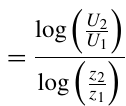
Figure 14. TI vs. R B . The blue box represents where both TI and R B agree on the stable conditions; the percentage (15%) represents the percentage of data points in this box. The red box represents where both TI and R B agree on the unstable conditions; the per- centage (17%) represents the percentage of data points in this box. Includes data filtered for tower 80m wind speeds between 3.5 and 25ms − 1 , 87m wind directions between 235 and 315 ◦ , and for nor- mal turbine operation.